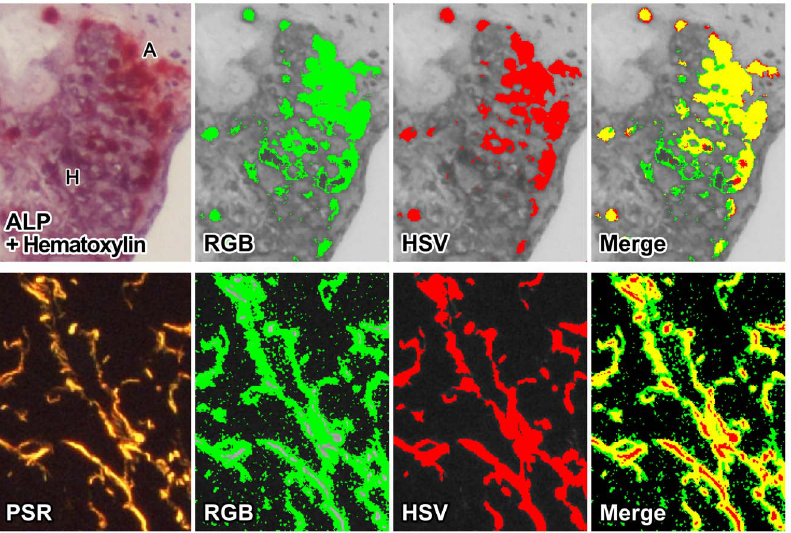
Figure 5. CSH is a powerful tool for a variety of stains. Common histological stains, displaying the fidelity of CSH . (Top panels): A mouse aorta stained with alkaline phosphatase (ALP, red) for detection of early calcification, with Gill’s hematoxylin as counterstaining (purple), which depicts advanced calcification. ALP stain is scarlet red (denoted ‘‘A’’ in the top left panel), while hematoxylin is a shade of purple (denoted ‘‘H’’ in the top left panel). Visually, the hematoxylin interferes with the ALP, making it difficult to see where the ALP stain begins and ends. We analyzed the section for ALP-positive area using both CSH and an RGB-based method. (Bottom panels): A mouse liver stained with picrosirius red staining visualized using polarized light microscopy for detection of fibrosis. We analyzed the section using both CSH and an RGB-based method. The RGB method was unable to register the brightest parts of the stain as positive (gray), and falsely interpreted stain artifacts as positive areas (green in both ‘‘Merge’’ images).